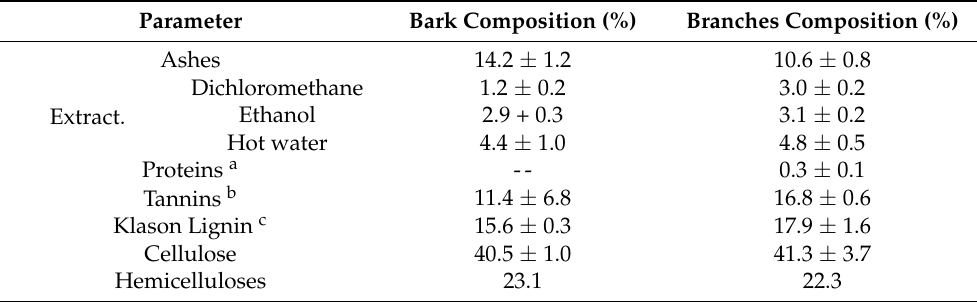
Table 1. Chemical Composition of barks and branches of Eucalyptus globulus (% dry material).